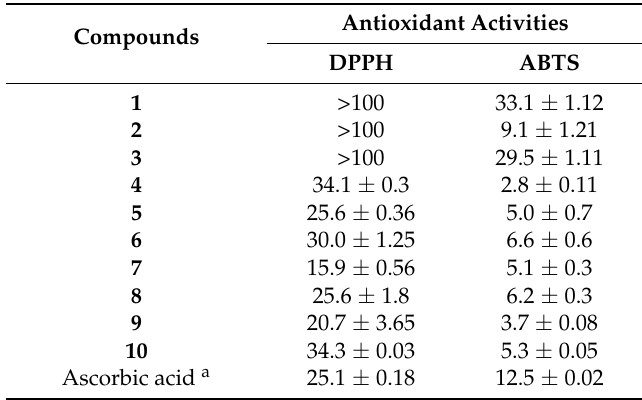
Table 2. Antioxidant activities of compounds 1 – 10 (IC 50 , µ M).